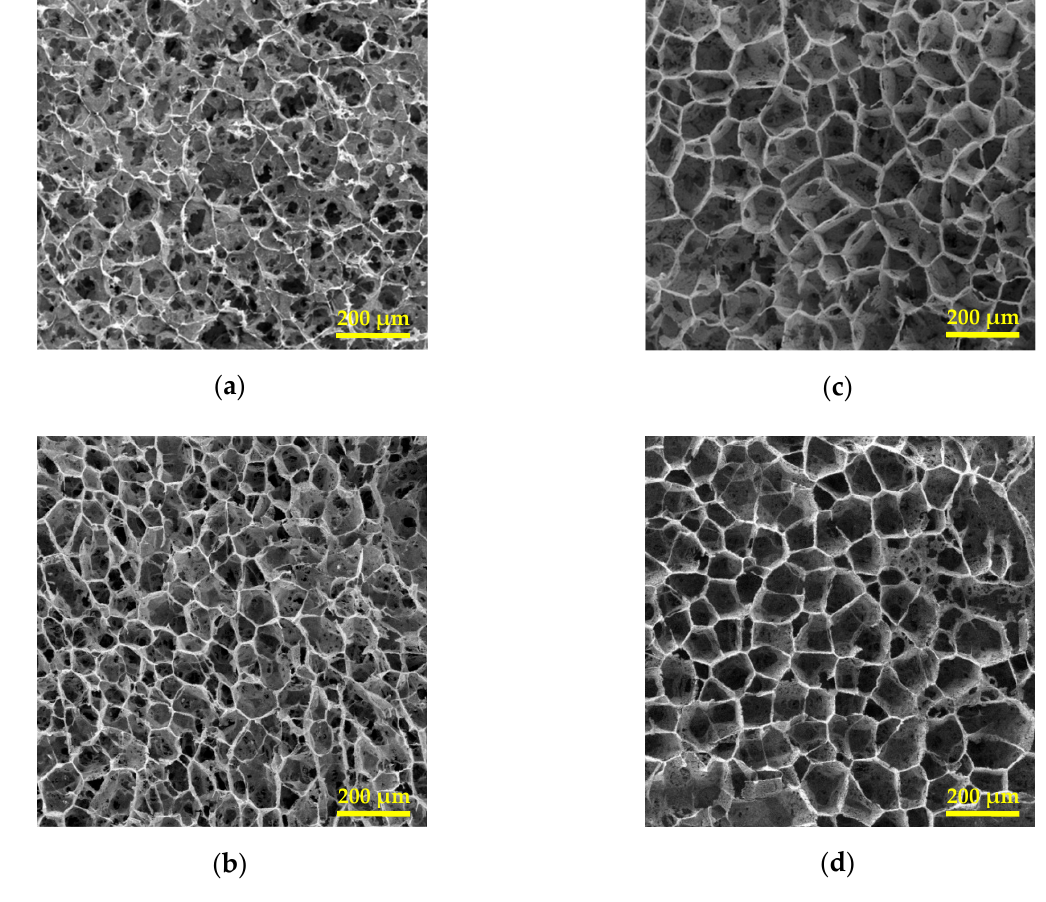
Figure 5. Scanning electron micrographs of the surface of PHBV scaffolds: ( a ) HBV5-R2, ( b ) HBV5-R6, ( c ) HBV12-R2, and ( d ) HBV12-R6.